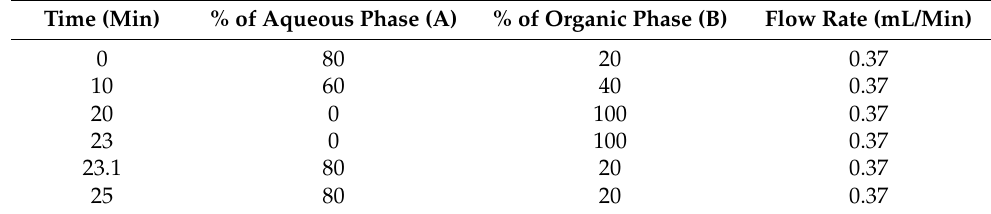
Table 3. Linear gradient chromatographic